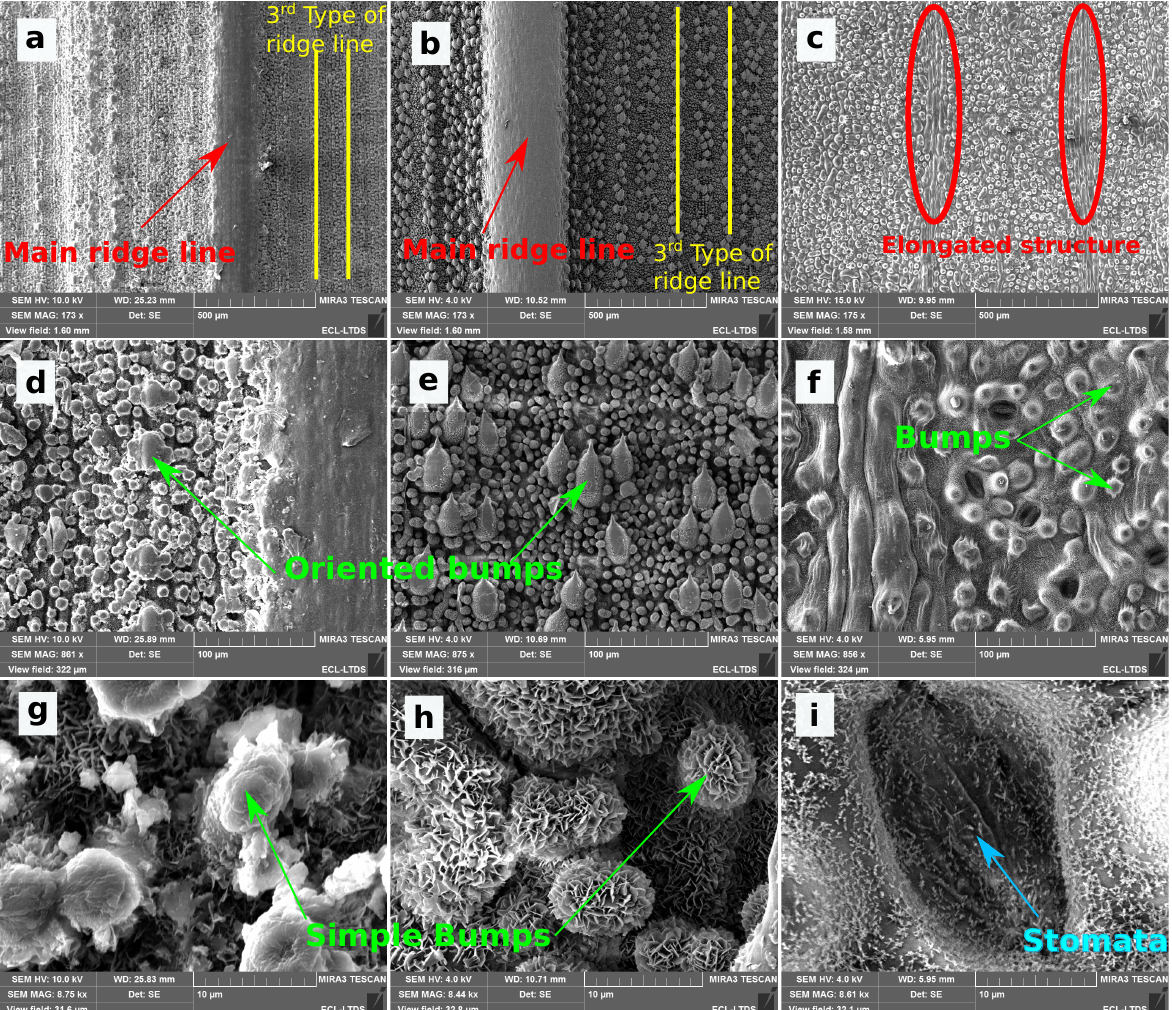
Figure 5. SEM images of leaves studied at different scales: ( a , d , g ) Phyllostachys, ( b , e , h ) Sasa, and ( c , f , i )